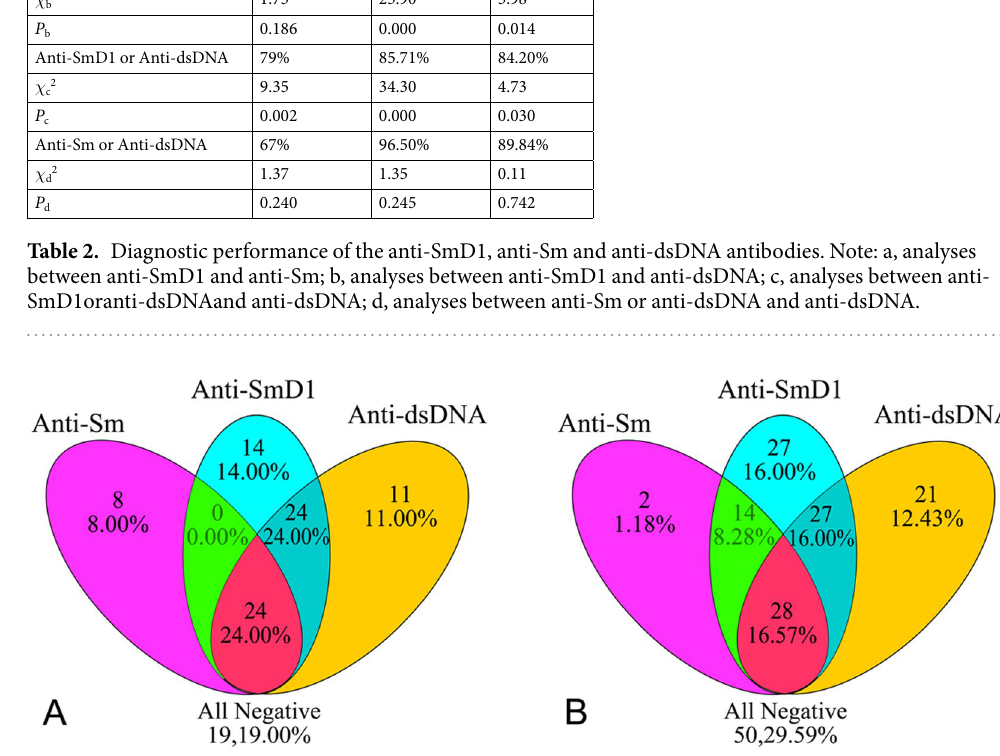
Figure 2. Cross-positivity for anti-SmD1, anti-Sm, and anti-dsDNA antibodies in SLE patients. ( A ) In100 naive SLE patients; ( B ) in169 non- naive SLE